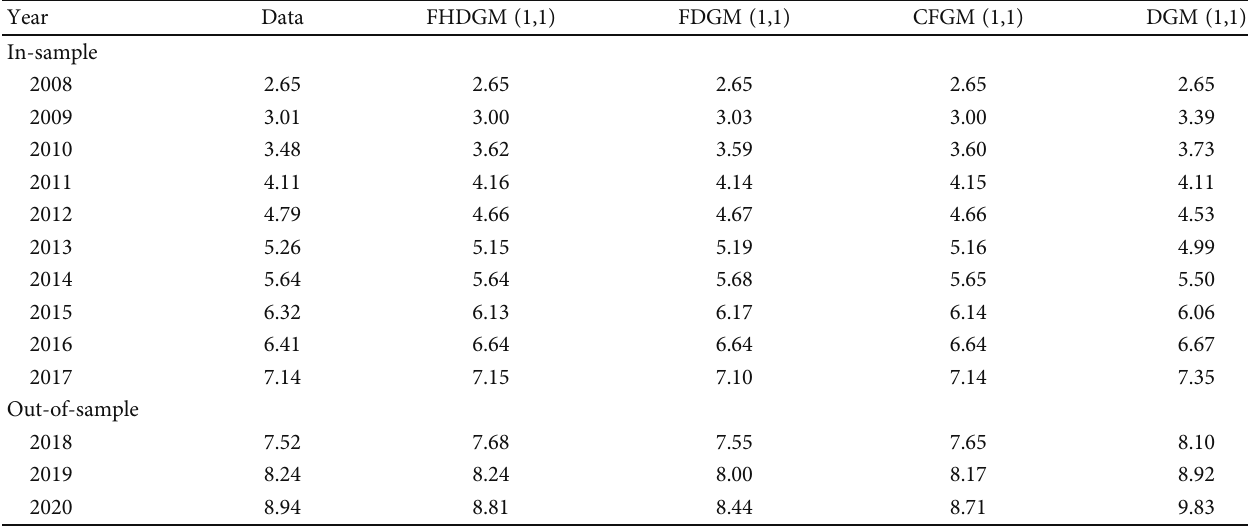
Table 11: Fitted and predicted values of the four models related to renewable energy consumption in all of Europe.